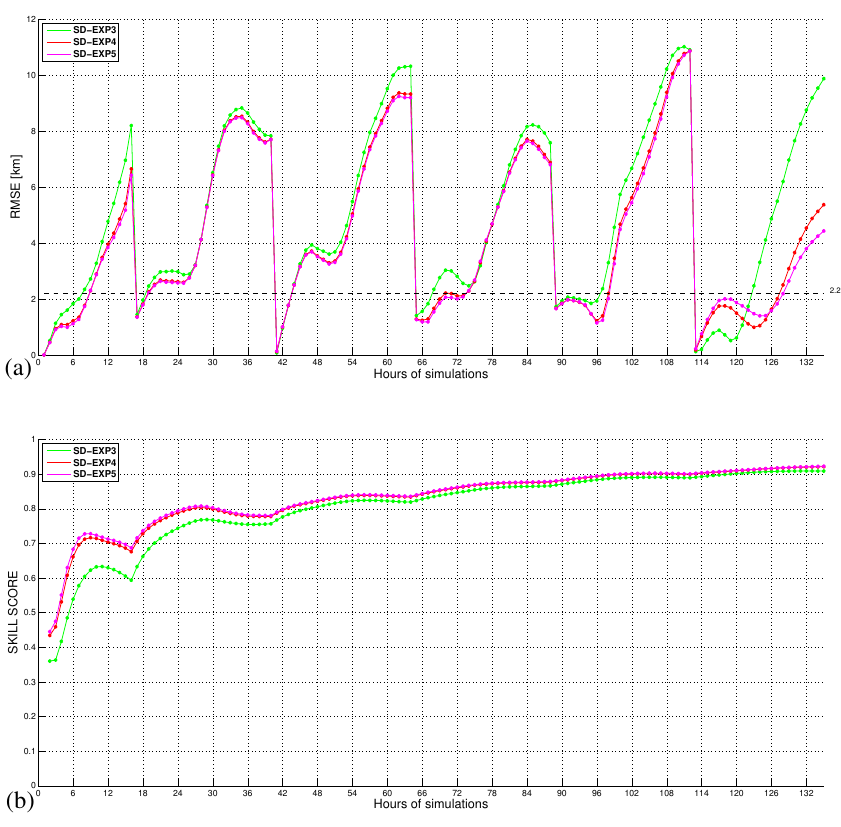
Fig. 8. RMSE (a) and skill score (b) between the observed and simulated trajectories of Fig. 7 as a function of the prediction time.